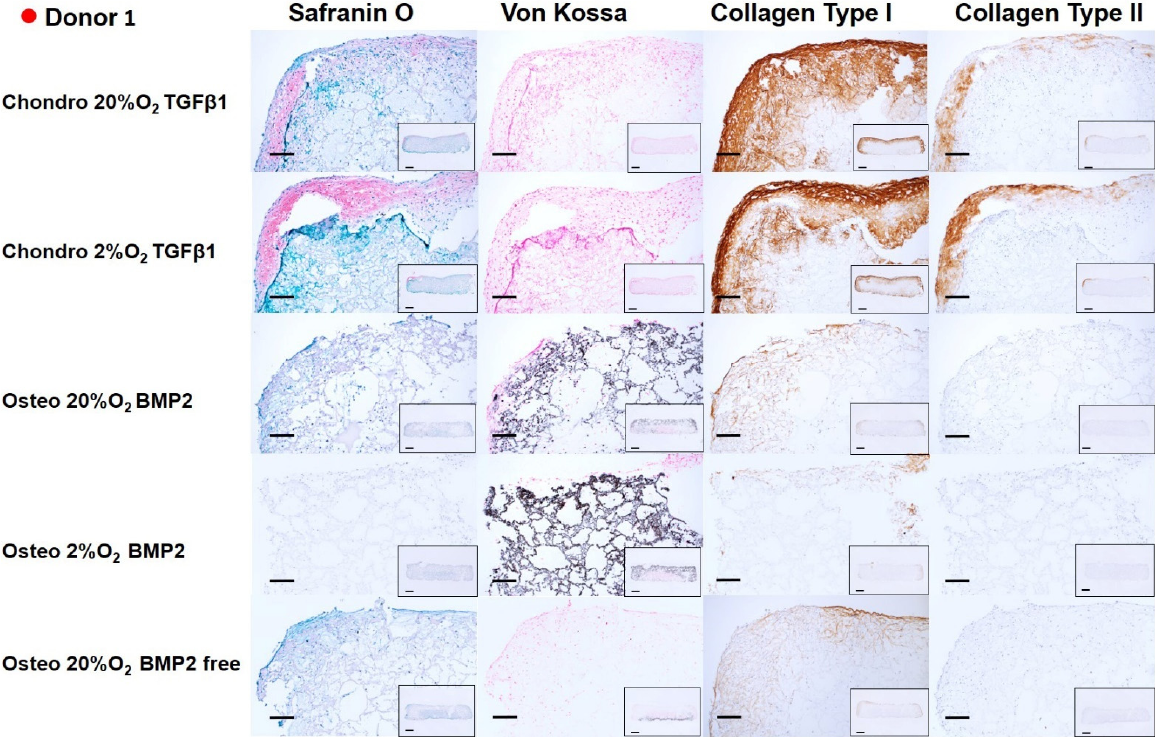
Figure 6. Chondrogenic and osteogenic hBMSC-constructs after 2 weeks of culture. Images showing a higher magnification of donor 1. Scale bar: 200 μ m. Inset: Images showing the full section of the constructs 1. Scale bar: 1 mm. Scaffolds were stained with safranin O/Fast Green, Von Kossa and immunohistochemically labelled for collagen type I and collagen type II. Chondrogenically differentiated groups showed higher Safranin O, Collagen Type I and Collagen type II deposition. The osteogenically differentiated groups with BMP2 are positive for Von Kossa staining.